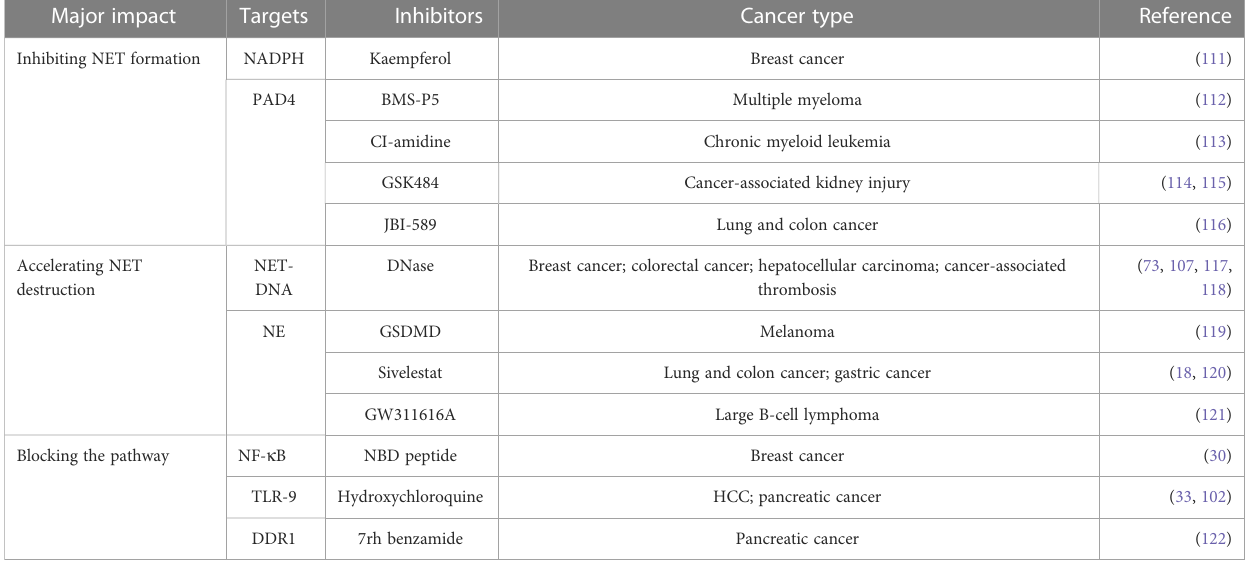
TABLE 1 Targeting NETs in multiple cancer